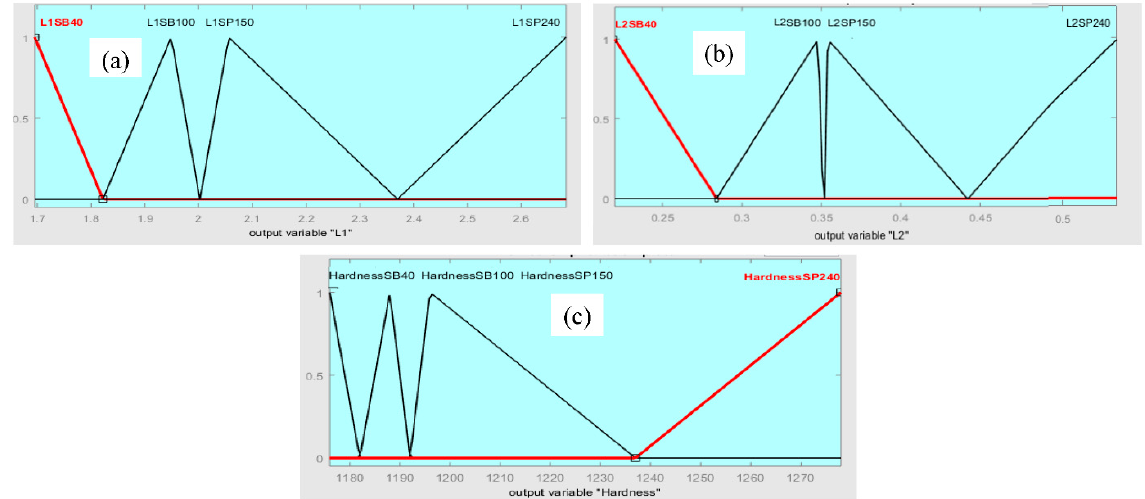
Figure 11. Outputs of fuzzy system.( a ) geometry L1; ( b ) geometry L2; ( c ) Figure 11 Outputs of fuzzy system.( a ) geometry L1; ( b ) geometry L2; ( c ) hardness